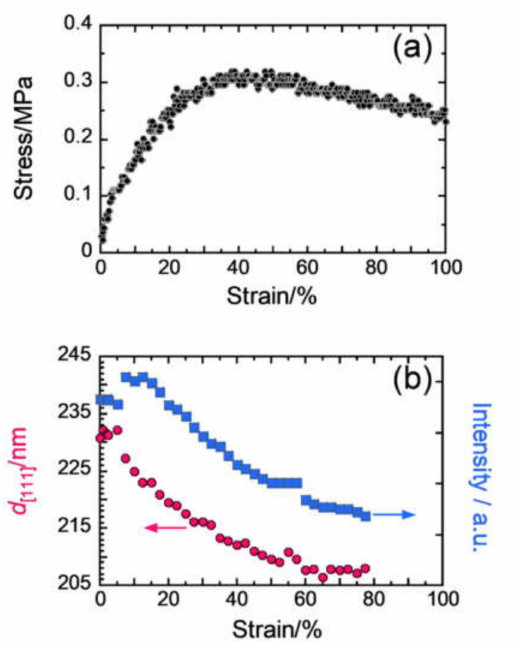
Figure 4. Stress–strain curve obtained during in situ USAXS measurement ( a ). ( b ) Strain dependence of the d -spacing of the [111] plane of the deformed fcc lattice, d [111], and the intensity of d [111] di ff raction. Reproduced with permission [19]. Copyright 2016,